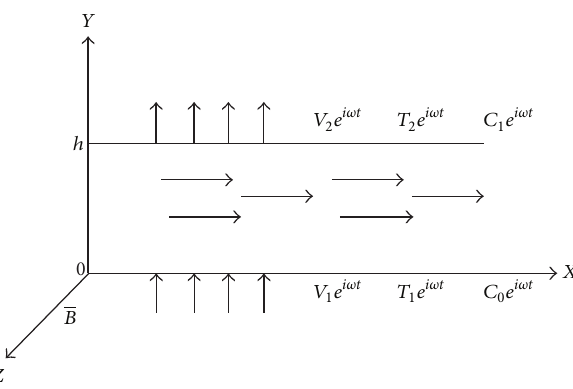
Figure 1: Schematic diagram of the fluid flow between parallel porous